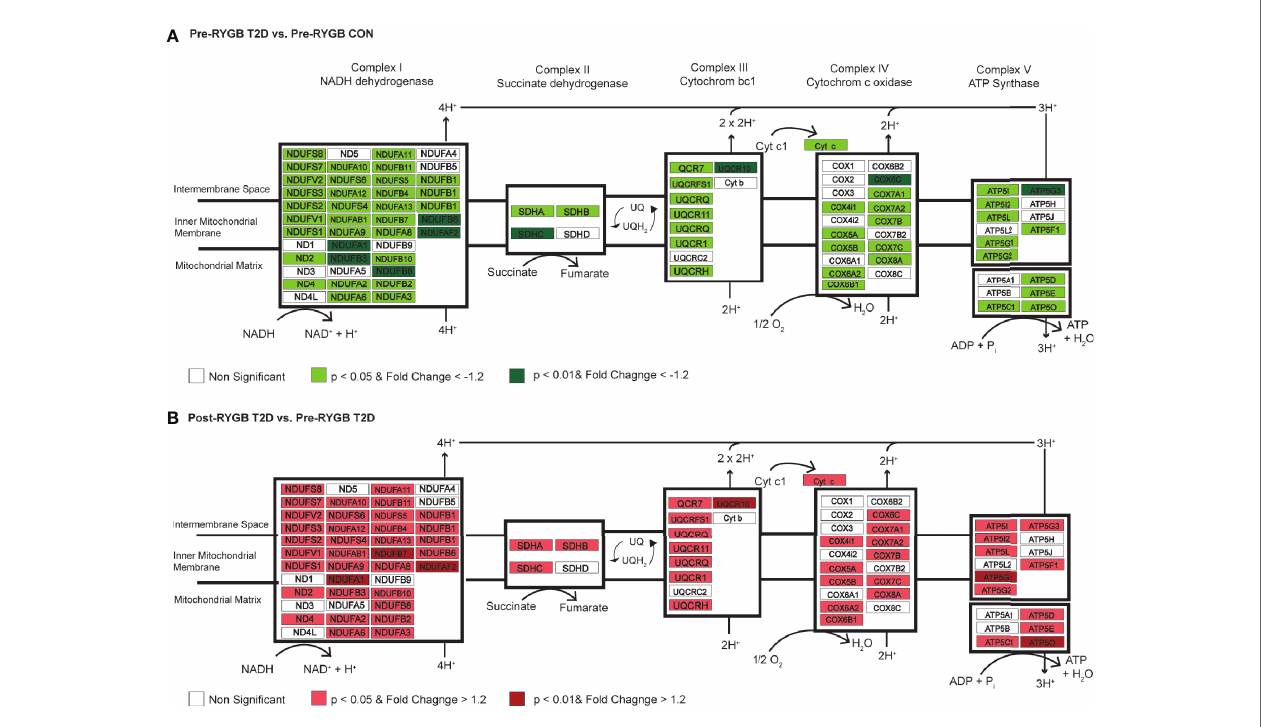
FIGURE 3 | Differential regulation of genes of the mitochondrial complexes between individuals with and without diabetes and pre- to post-surgery in individuals with diabetes. (A) Differentially regulated genes in Complex I, II, III, IV, and ATP Synthase in skeletal muscle of individuals with and without diabetes prior to surgery. Using an expanded gene list to include genes with p < 0.05, FC > − 1.2 (lighter red shading; Supplementary Table S6 ), we show consistent downregulation of genes in mitochondrial complexes in individuals with diabetes prior to surgery. Green shading indicates p < 0.01 and FC > − 1.2. (B) Differentially regulated genes in Complex I, II, III, IV, and ATP Synthase in skeletal muscle of individuals with diabetes pre- to post-surgery. Using an expanded gene list to include genes with p < 0.05, FC > − 1.2 (lighter green shading; Supplementary Table 6 ), we show consistent upregulation of genes in mitochondrial complexes 1 year post-surgery. Red shading indicates p < 0.01 and FC >